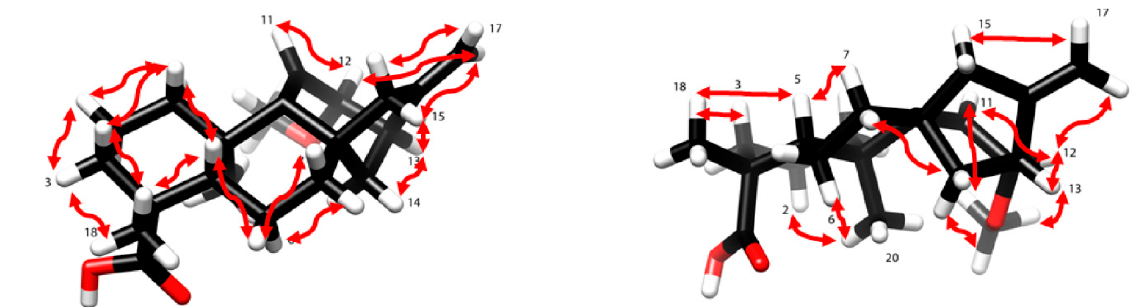
Figure 2. Some of the key NOE correlations observed for compound 1 . The NOESY (Nuclear Overhauser Effect Spectroscopy) spectrum (800 MHz, CDCl 3 , 25 °C, 700 ms mixing time) is shown in the Supplementary Materials.